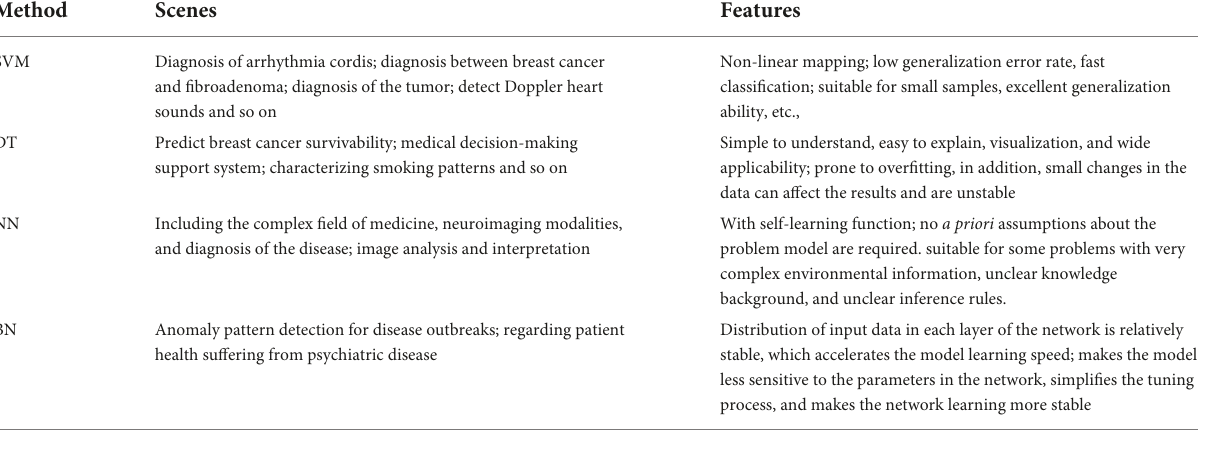
TABLE 2 Main application of clustering methods in healthcare big data. Method